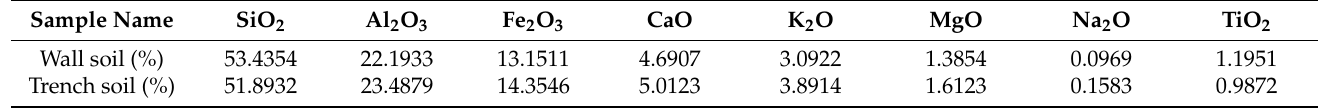
Table 3. Oxide composition of soil sample.